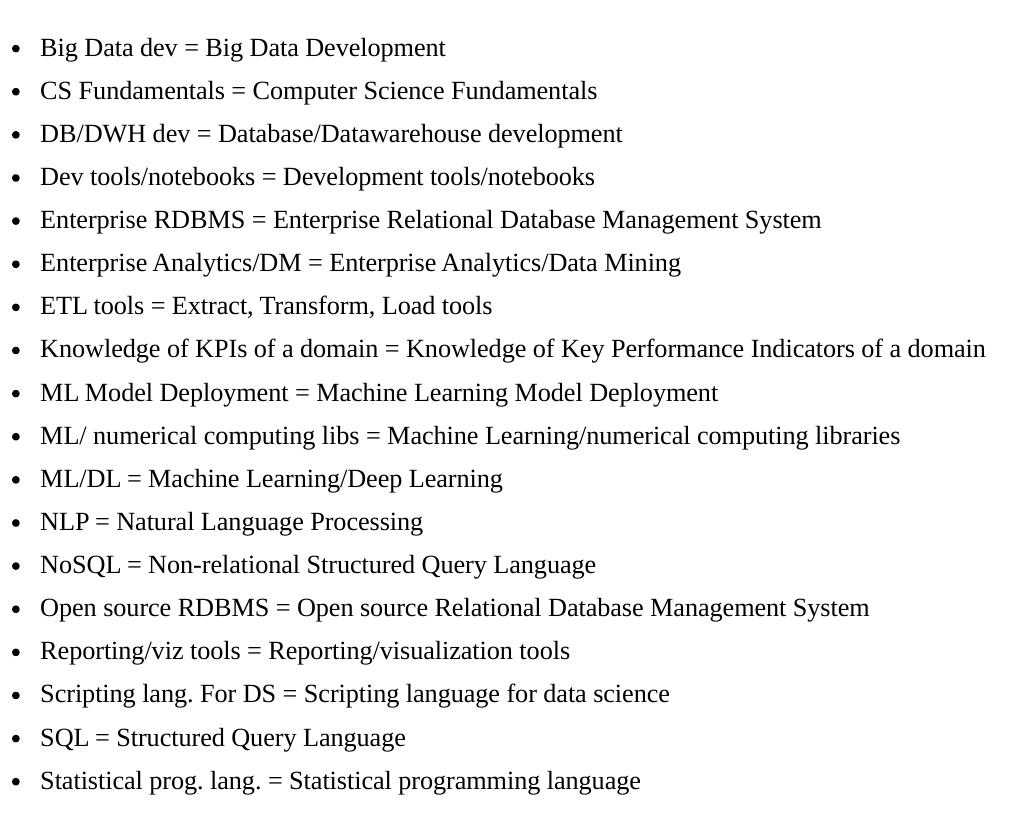
Figure 3. The listing and a summary of questionnaire responses from the identified data science